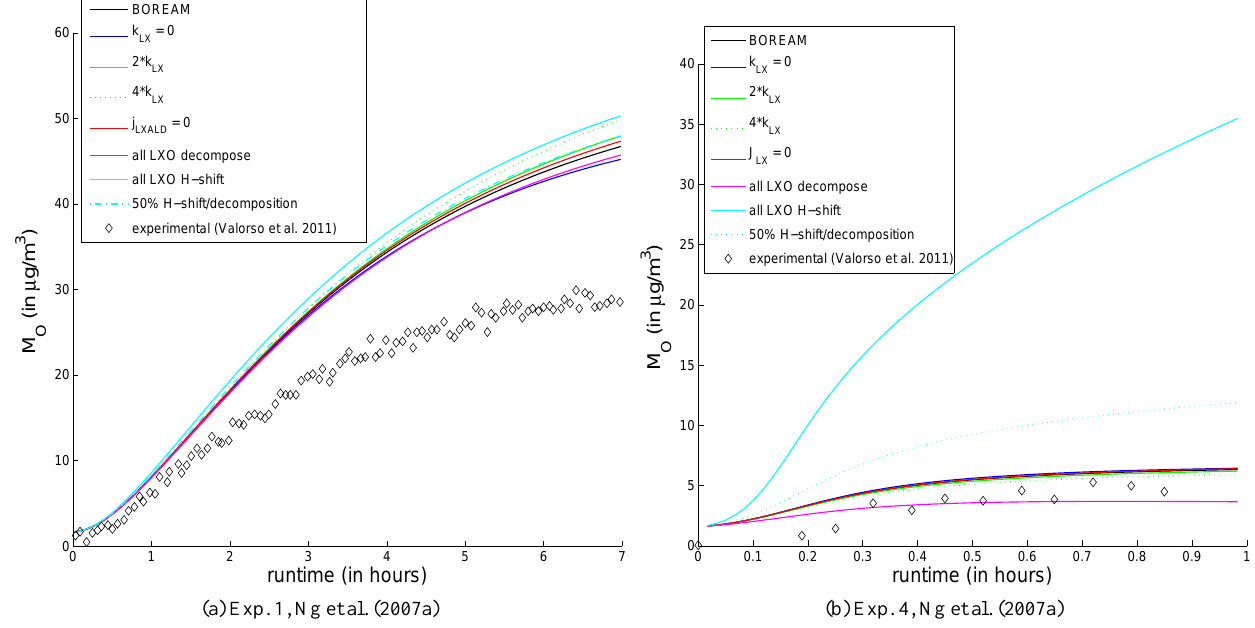
Fig. 2. Time evolution for the Experiments 1 (low-NO x ) and 4 (high-NO x ) of Ng et al. (2007a), based on data presented in Valorso et al. (2011). Shown are sensitivity tests for SOA yields to the assumed reaction constant with OH of the generic part of generic species classes, k LX , the J-value j LXALD of this generic part and the branching ratios of generic alkoxy radicals.